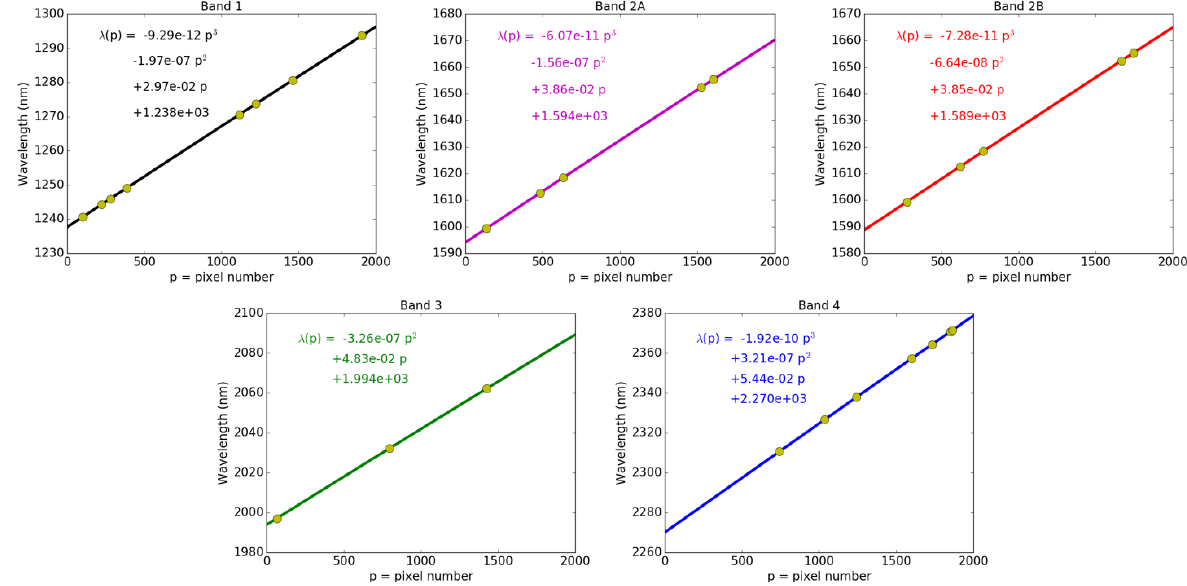
Figure 13. Dispersion functions calculated for GHOST bands 1, 2A, 2B, 3, and 4. Argon emission lines are used for all except Band 4, where neon emission lines are used instead. We used neon for Band 4 because the identification of which measured line corresponds to which line listed in the NIST database was much less ambiguous than for argon in this wavelength